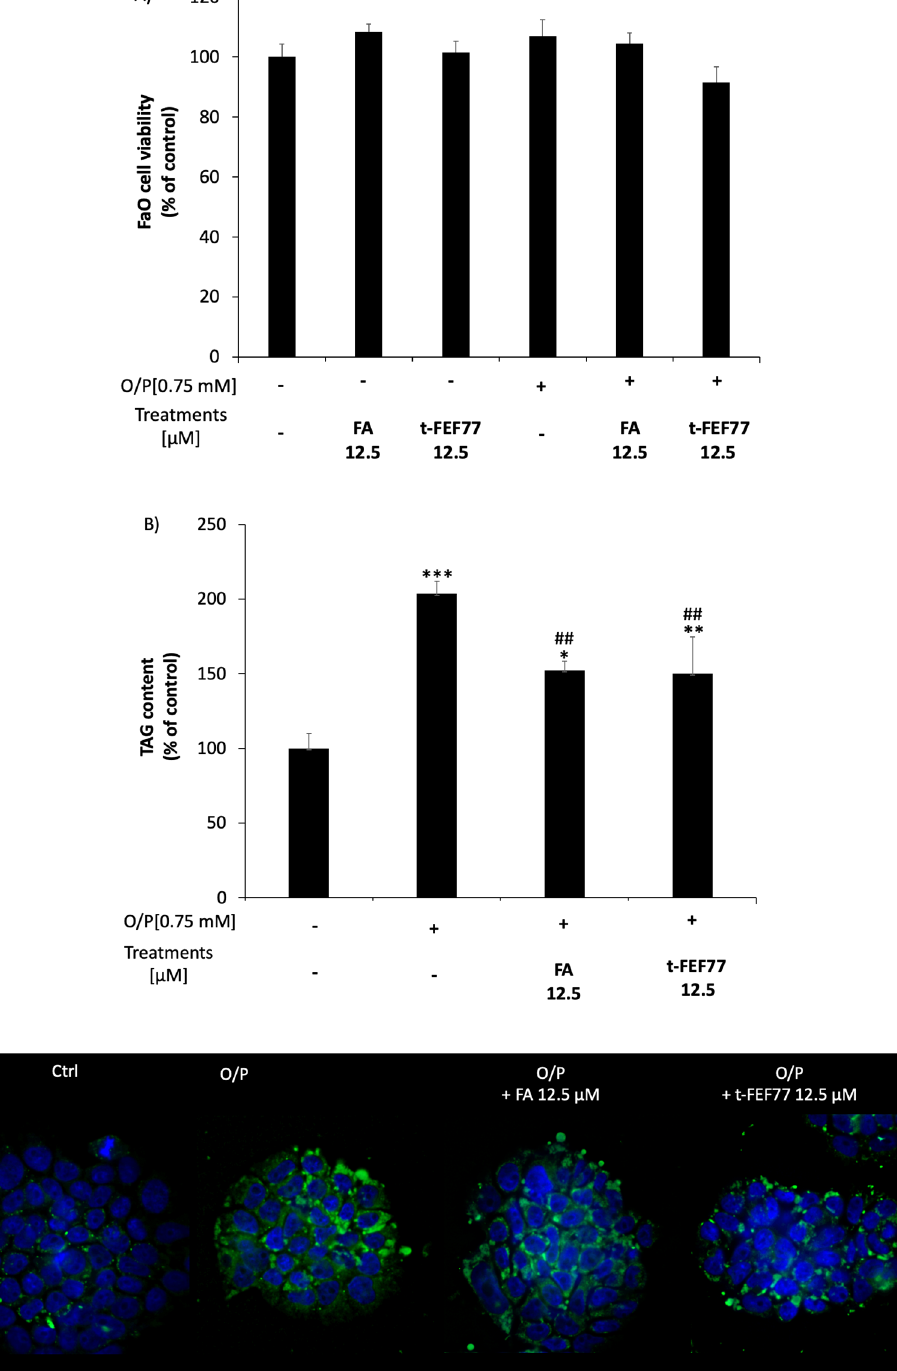
Figure 5. Effects of FA and t-FEF77 in FaO cells treated in the absence or presence of O/P. ( a ) FaO rat hepatoma cell viability after a 3 h treatment with or without O/P and subsequent treatment with 12.5 μ M polyphenols (FA or t-FEF77); ( b ) Intra- cellular TAG content in steatotic FaO treated or not with 12.5 μ M polyphenols (FA or t-FEF77). ( c ) Fluorescence microscopy visualization of neutral lipids by BODIPY 493/503 fluorescence (green). Nuclei are visualized by DAPI fluorescence (blue) (magnification 63X; scale bars: 10 μ m). Data are expressed as percent vs. control (0). Values are mean ± S.D from at least three independent experiments. Significant differences are denoted by symbols on bars (* p ≤ 0.05, ** p ≤ 0.01, *** p ≤ 0.001 vs control; ## p ≤ 0.01 vs O/P).